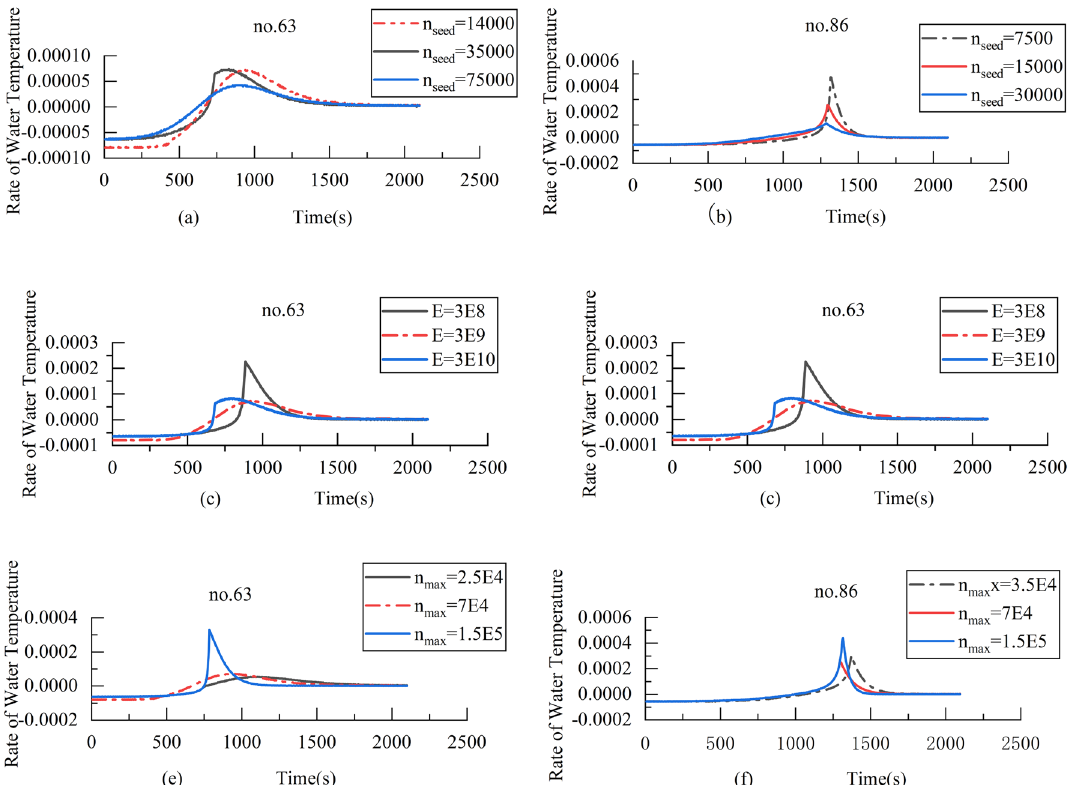
Figure 8. ( a ) Rate of water temperature versus time of n seed for the laboratory experiment no. 63; ( b ) rate of water temperature versus time of n seed for the laboratory experiment no. 86; ( c ) rate of water temperature versus time of E for the laboratory experiment no. 63; ( d ) rate of water temperature versus time of E for the laboratory experiment no. 86; ( e ) rate of water temperature versus time of n max for the laboratory experiment no. 63; ( f ) rate of water temperature versus time of n max for the laboratory experiment no.